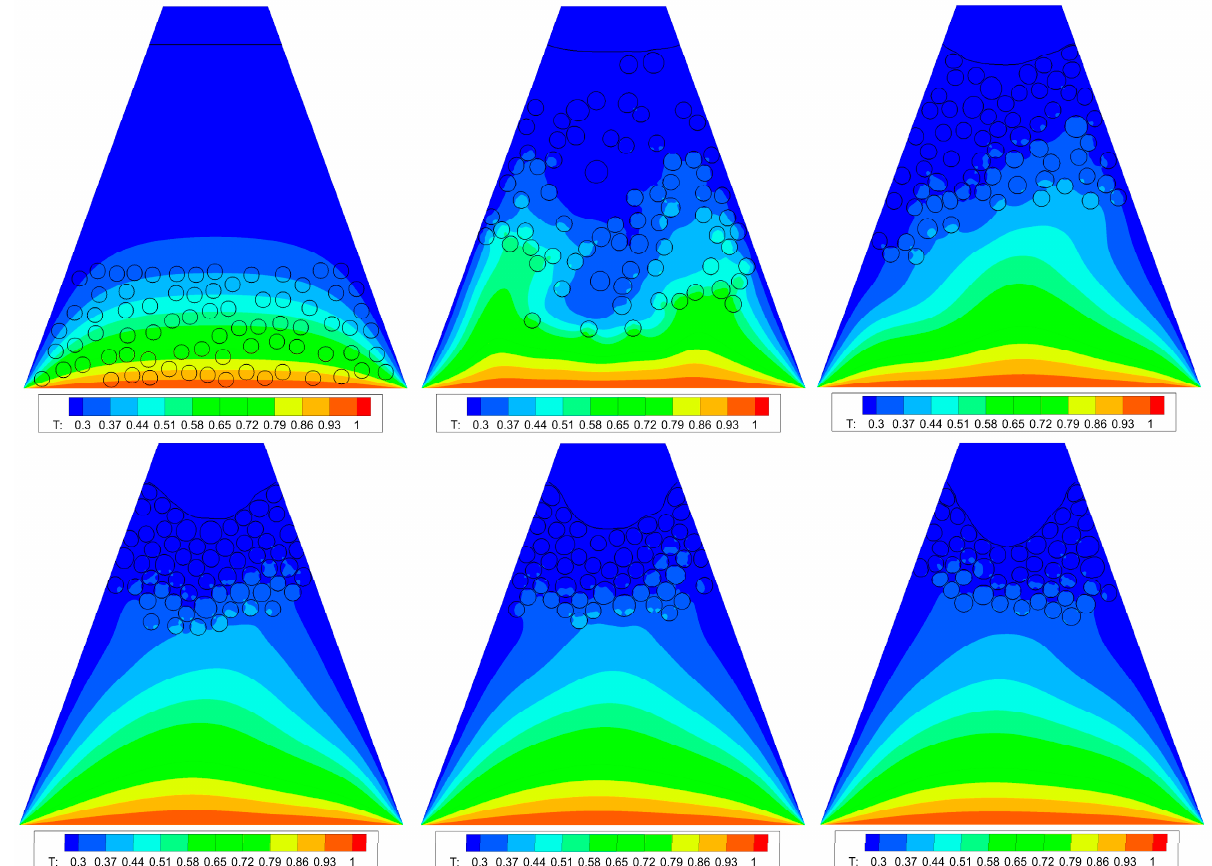
Figure 6. Different time steps starting from the rising of random bubbles to foam generation. Temperature contours are shown, while the bubbles and liquid interfaces are clearly visible.